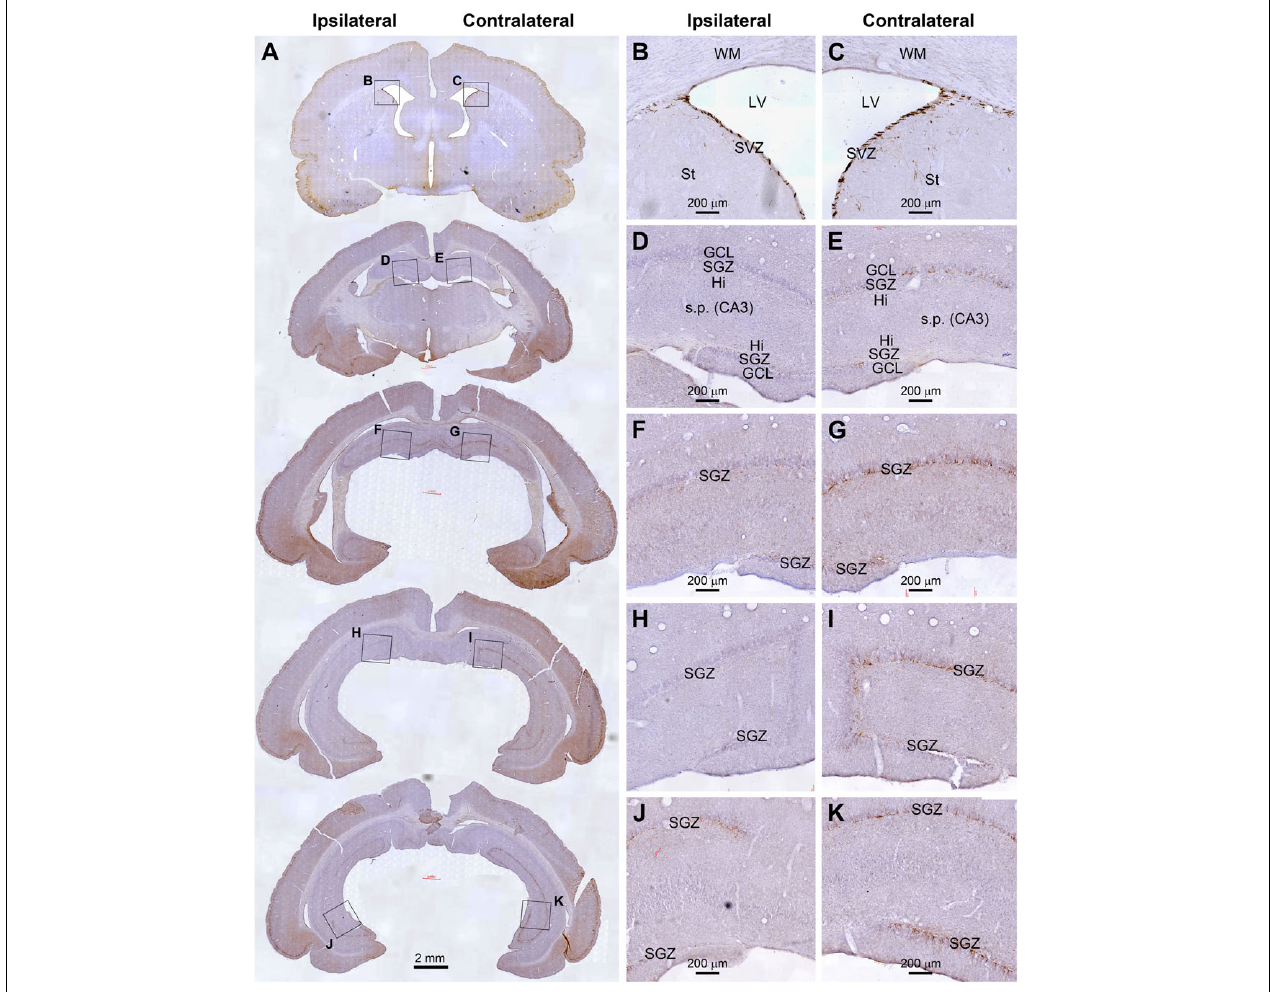
FIGURE 3 | Reduced DCX immunolabeling in the hippocampus in an animal with unilateral extracranial 125 I seed radiation at 0.6 mCi surviving 30 days. Panel arranges and scale bars are as indicated. The amount of immunolabeling in dentate gyrus (DG) are apparently asymmetric between the two hemispheres (A–C) . However, the labeling at the subventricular zone (SVZ) at the septal level appears comparable between the two sides. DCX labeling in the DG is greatly reduced in the ipsilateral side relative to the contralateral side from the rostral to caudal range of hippocampus over the dorsal and temporal subregions of the DG (A,D–I) . The reduction of DCX + profiles in the most ventral part of the ipsilateral DG appeared less prominent relative to the contralateral counterpart (A,J,K)